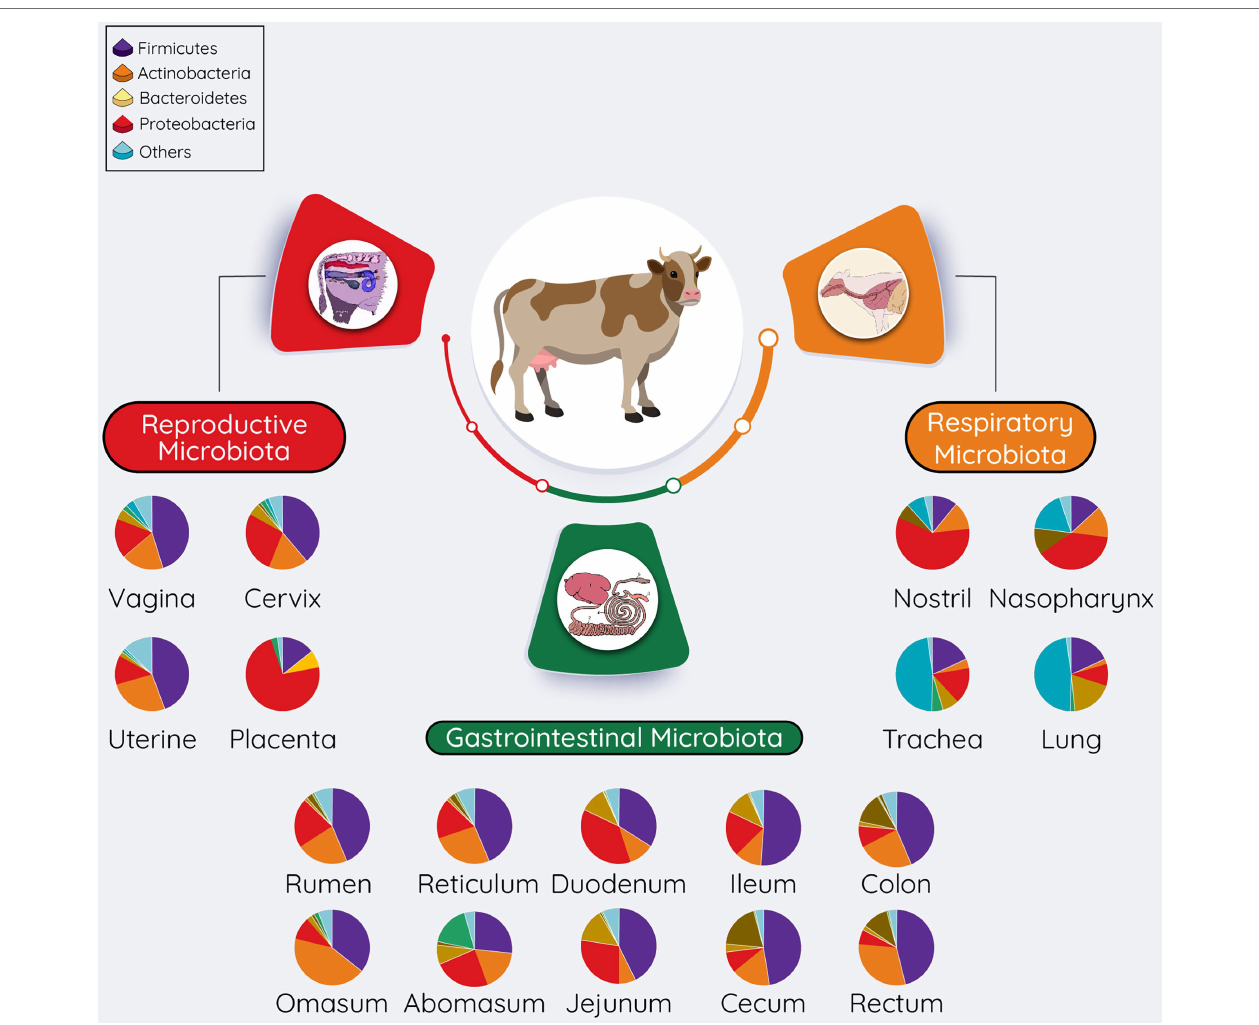
FIGURE 3 | Overall summary of the microbial communities residing within the respiratory, gastrointestinal, and reproductive tracts of cattle. The pie chart represents the most relatively abundant bacterial phyla. The relative abundance of these phyla present in pie charts was adapted from McMullen et al. (2020a) (respiratory tract), Mao et al. (2015), and Holman and Gzyl (2019) (gastrointestinal tract), reproductive tract (Amat et al., 2021b; vagina; Wang et al., 2018; Cervix; Quereda et al., 2020;